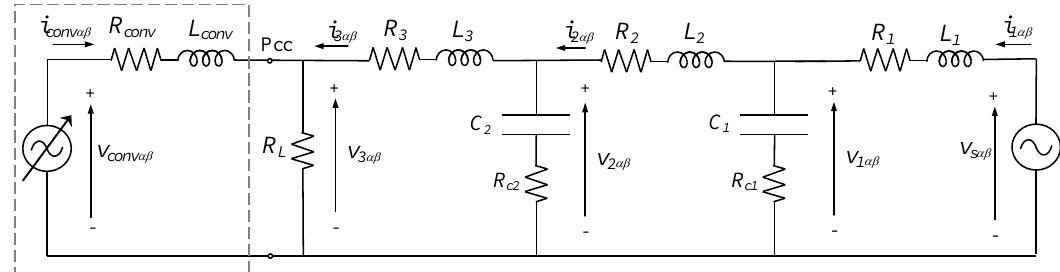
Figure 3. Equivalent AC grid model and converter providing active impedance at selective frequencies (ACISEF) connected at the Pcc.